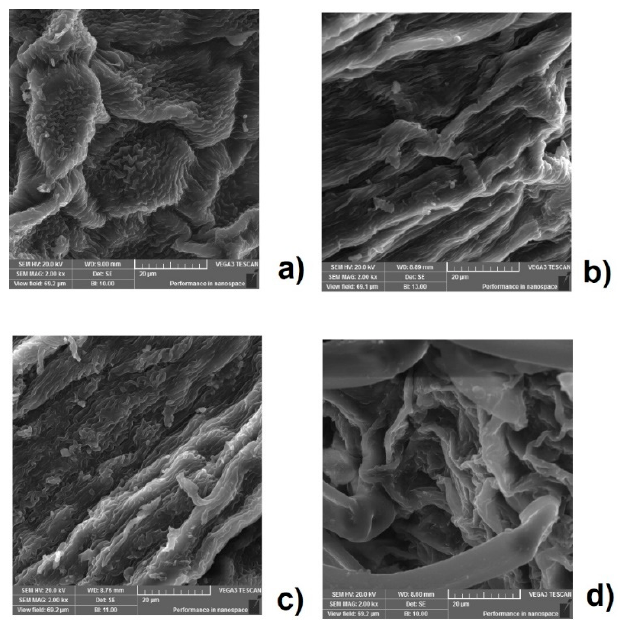
Figure 4. SEM (scanning electron microscopy) micrographs of black locust flowers: ( a ) without treatment; ( b ) after maceration; ( c ) after Soxhlet extraction, and ( d ) after the UAE (Ultrasound-assisted extraction).